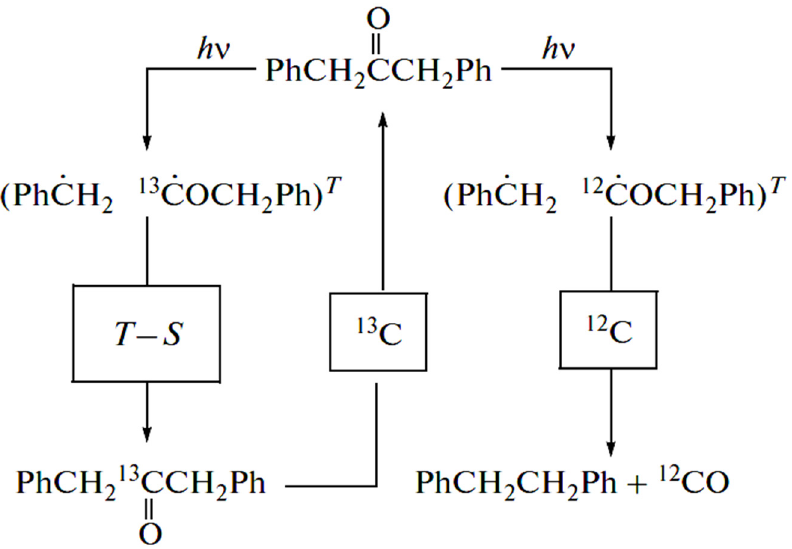
Figure 1. Fractionation of 13 C and 12 C isotopes by photolysis of dibenzyl ketone. (Adapted with permission from Ref. [30], 2010, A.L. Buchachenko.)